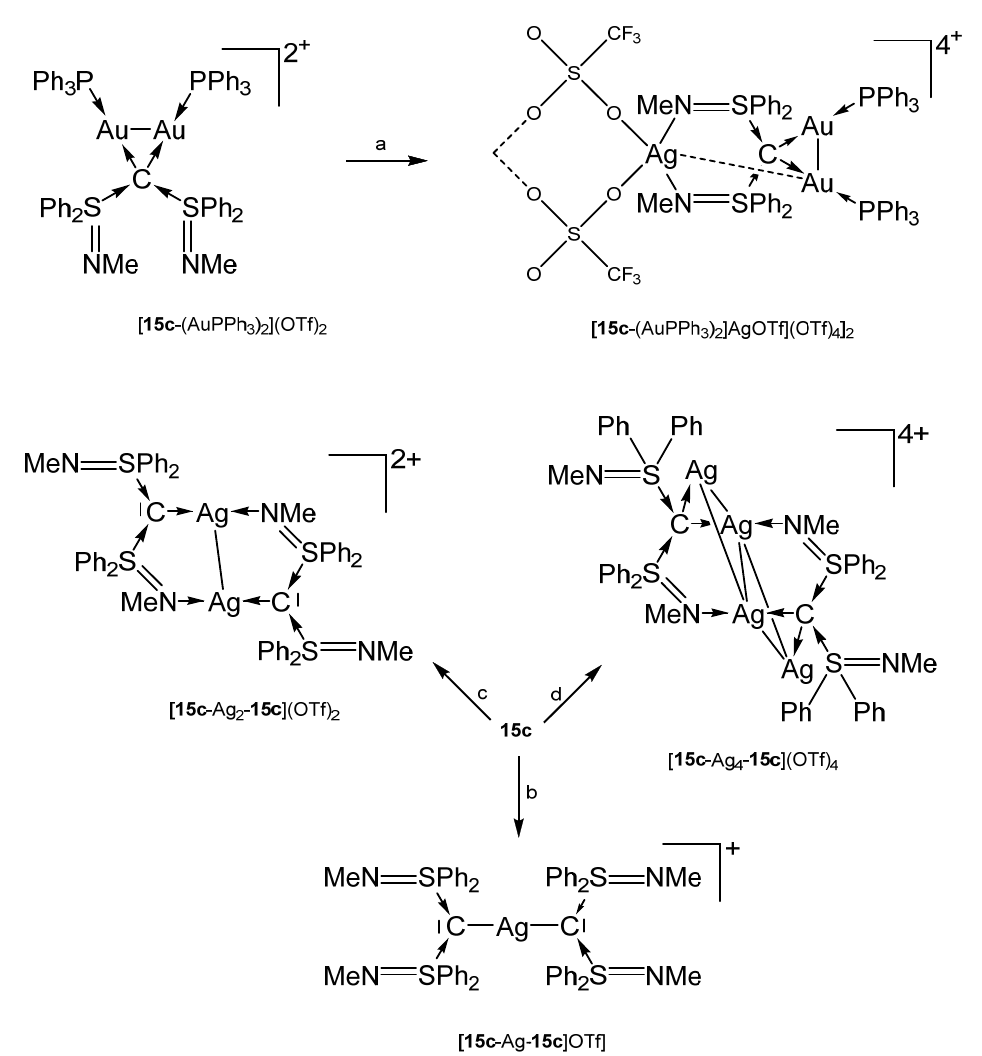
Figure 19. Carbone with Se and S based ligands